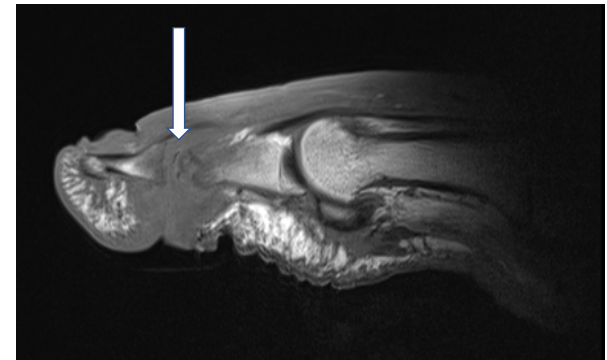
Figure 1. T1-weighted sagittal images of a right first interpha- langeal joint demonstrating osteomyelitis of the head of the prox- imal phalanx and the basis of the distal phalanx. Infectious os- teomyelitis is indicated by fat mark suppression in T1 (arrow). Mag- netic resonance images with consent of the patient.